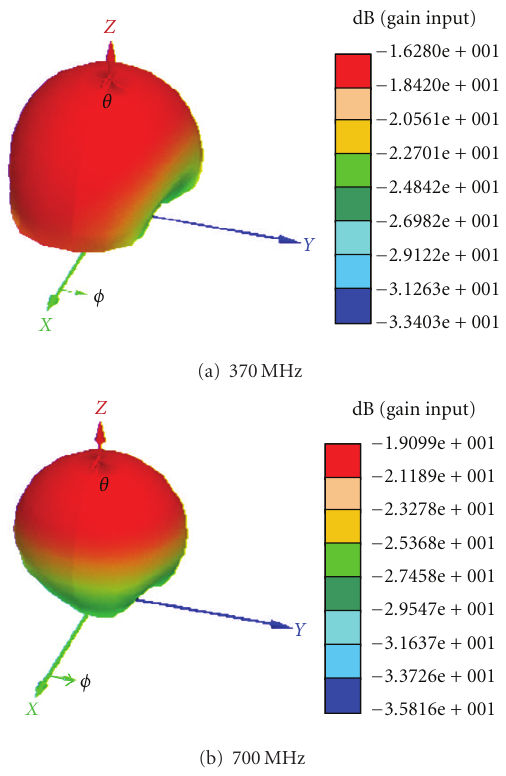
Figure 7: 3 D Radiation patterns at the select frequency.